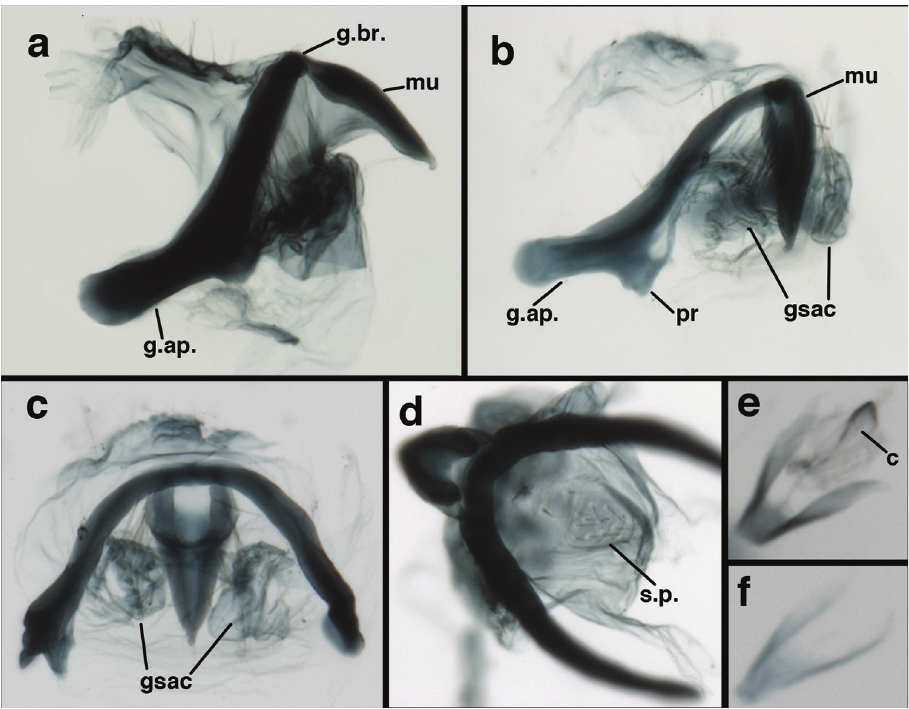
Figure 56. Ungla laufferi (Navás): Male genitalia, ( a ) gonarcal complex, lateral with gonosaccus col- lapsed ( b ) gonarcus, lateral with gonosaccus partially expanded ( c ) gonarcus frontal, gonosaccus partially expanded ( d ) gonarcus, posterior with subanal membrane and plate folded below ( e ) hypandrium inter- num, well sclerotized ( f ) hypandrium internum, slightly teneral. c comes gsac gonosaccus g.ap. gonarcal apodeme g.br. gonarcal bridge mu mediuncus pr unarticulated process on frontal margin of gonarcal apodeme s.p. setose subanal plate (all: Peru, Lima; a, d, e IFML; b, c, f